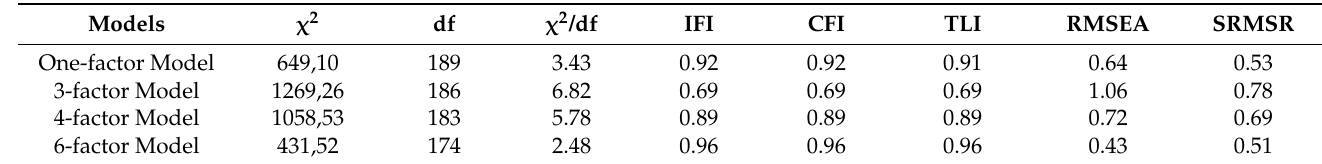
Table 2. Fit indices of the models after CFA.